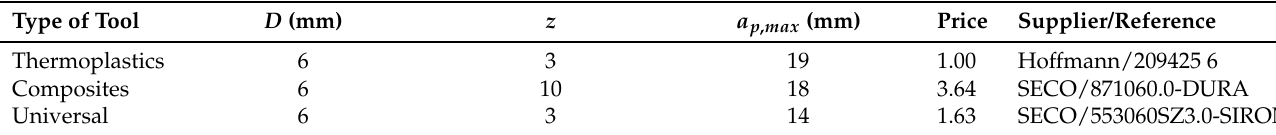
Table 1. Main characteristics of the selected tools.